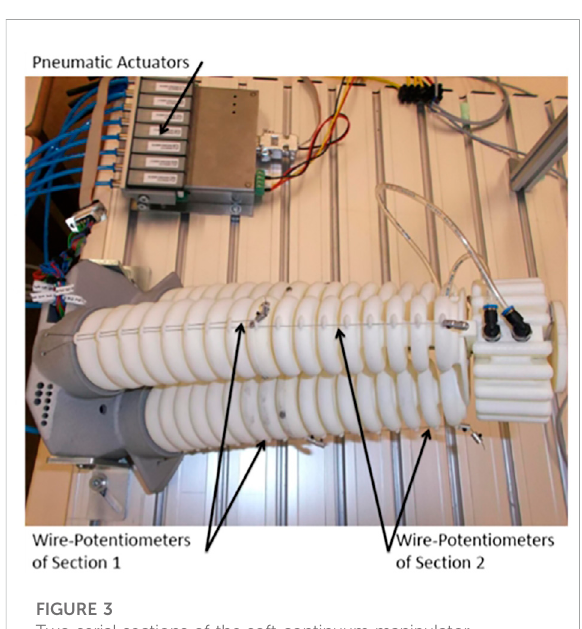
FIGURE 3 Two serial sections of the soft continuum